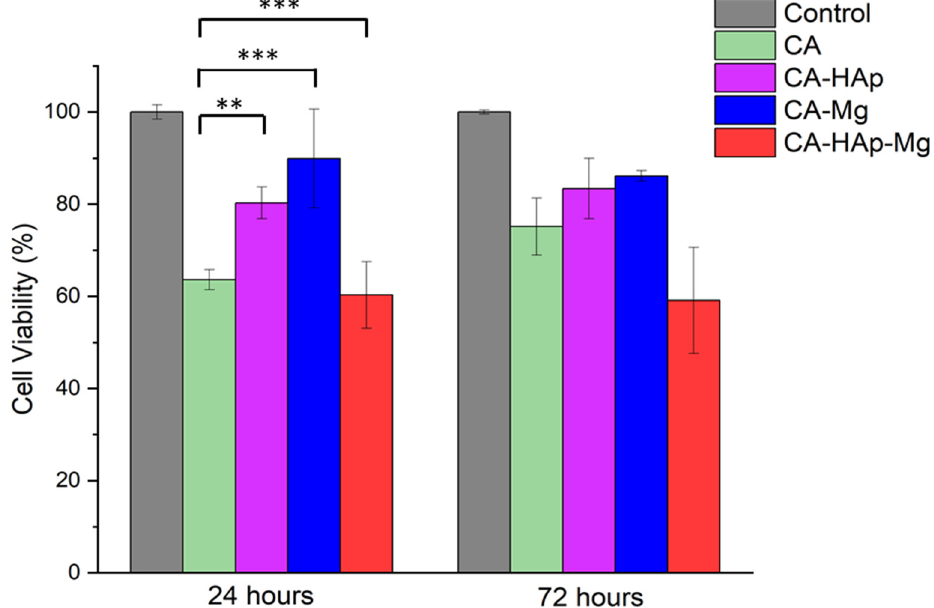
Figure 13. The cell viability, measured by the MTT assay for direct contact: * p < 0.01, ** p < 0.001, and *** p < 0.0001 (analyzed by means of two-way ANOVA with Tukey’s post hoc analysis).